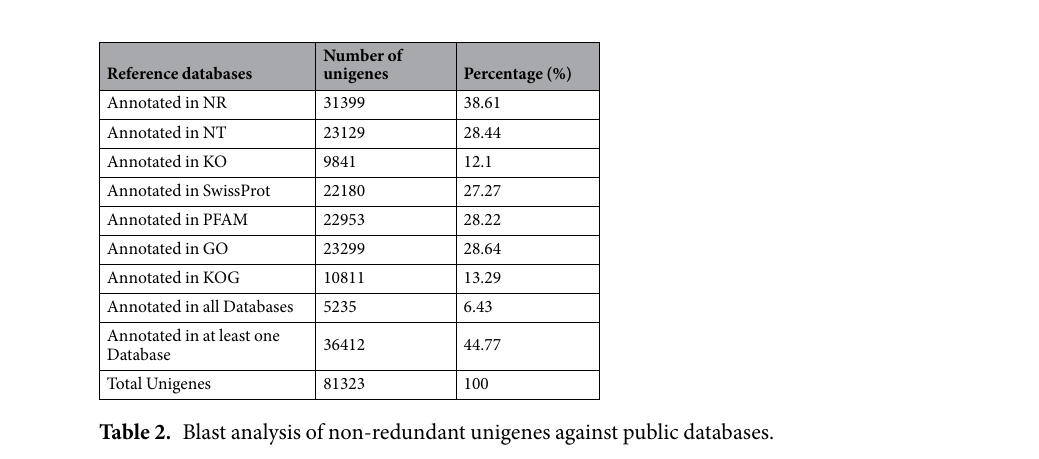
Table 2. Blast analysis of non-redundant unigenes against public